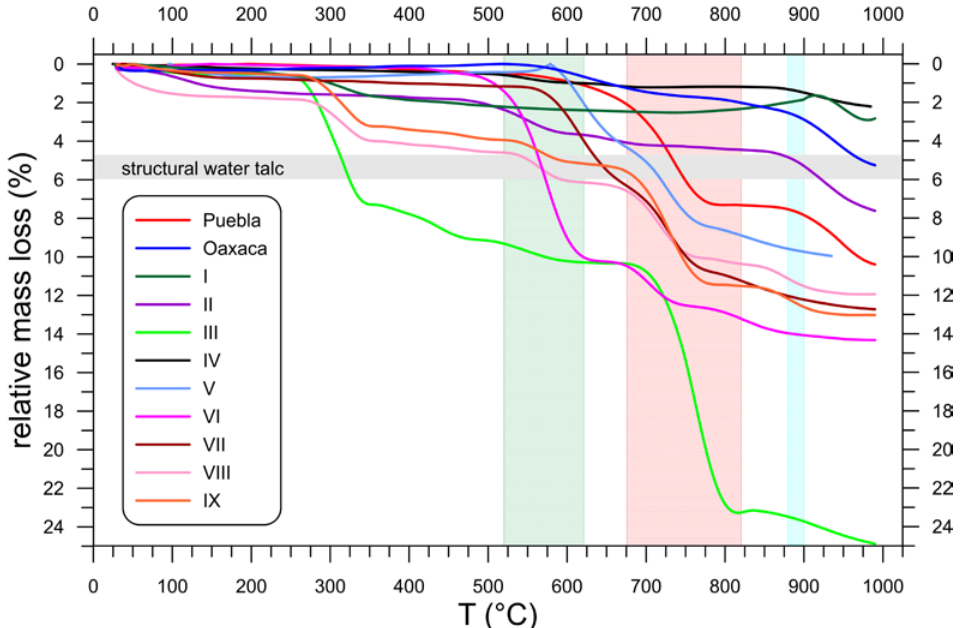
Figure 7. Thermogravimetric (TG) curves for different types of talc. Mass losses associated with carbonate ( red ), chlorite ( green ) and decomposition of talc ( blue ) were drawn as shaded bands.